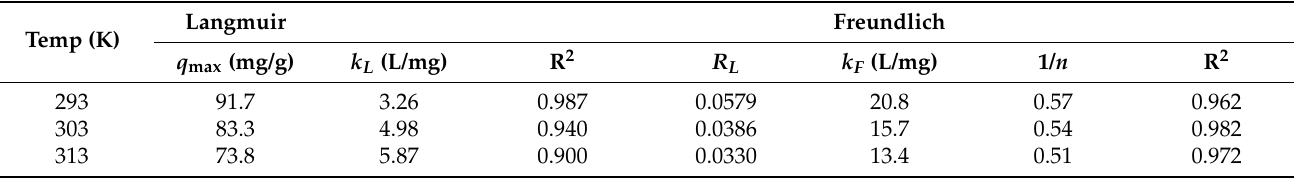
Figure 6. ( a ) Langmuir and ( b ) Freundlich models of adsorption MB on PGO aerogels at different temperatures. Table 1. Isothermal constants for MB adsorption on PGO